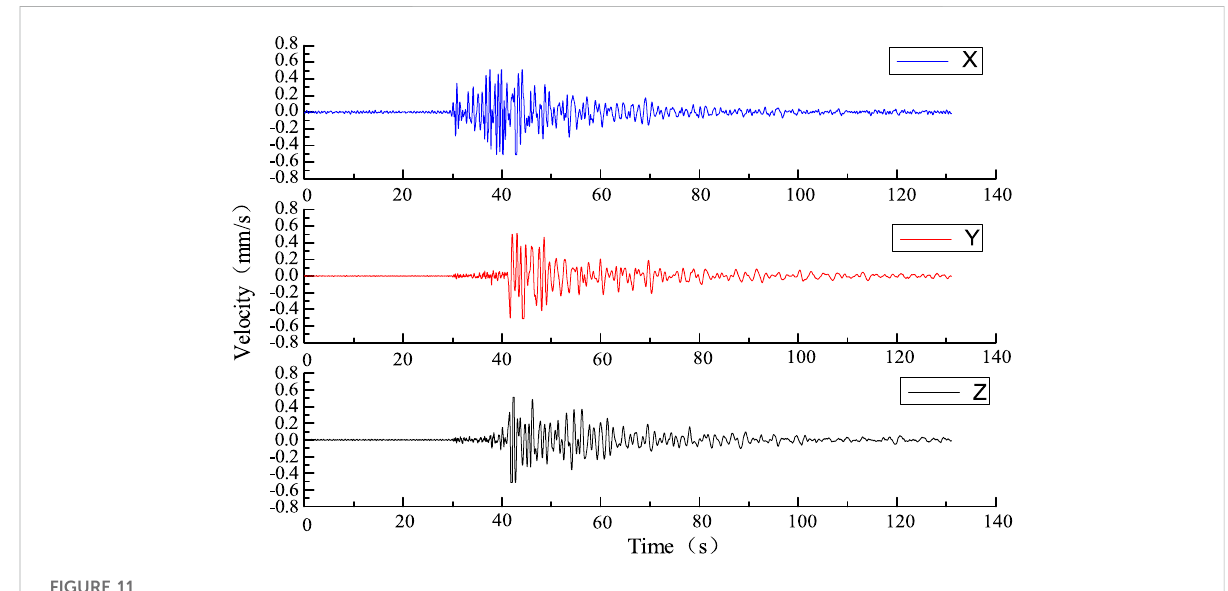
FIGURE 11 Schematic diagram of microseismic signal in microseismic monitoring